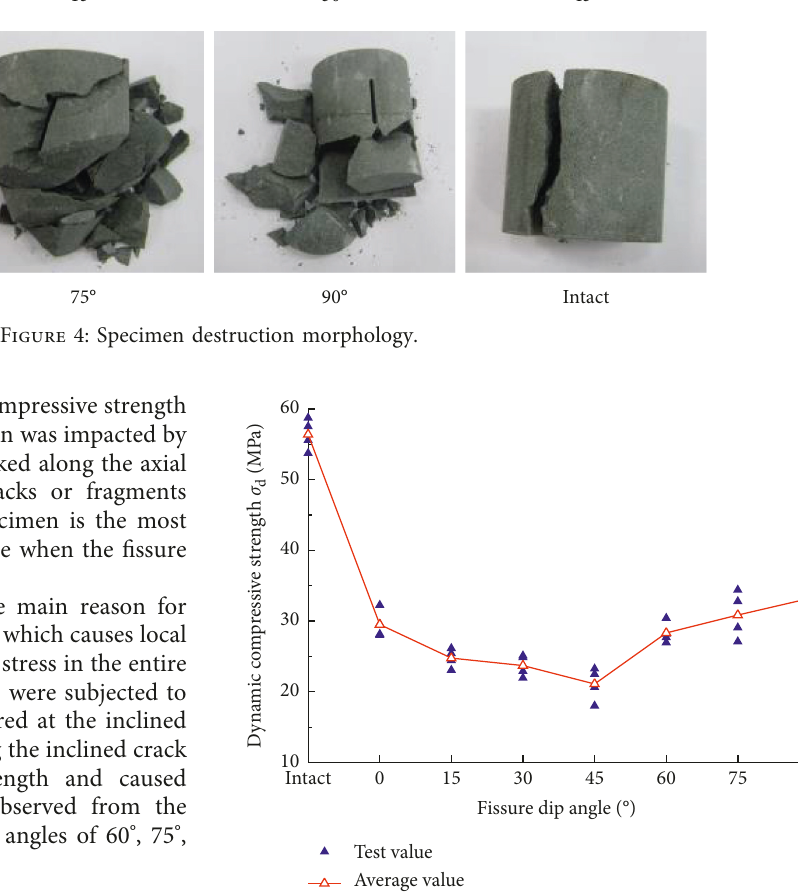
Figure 5: Relationship between the fissure angle and dynamic compressive